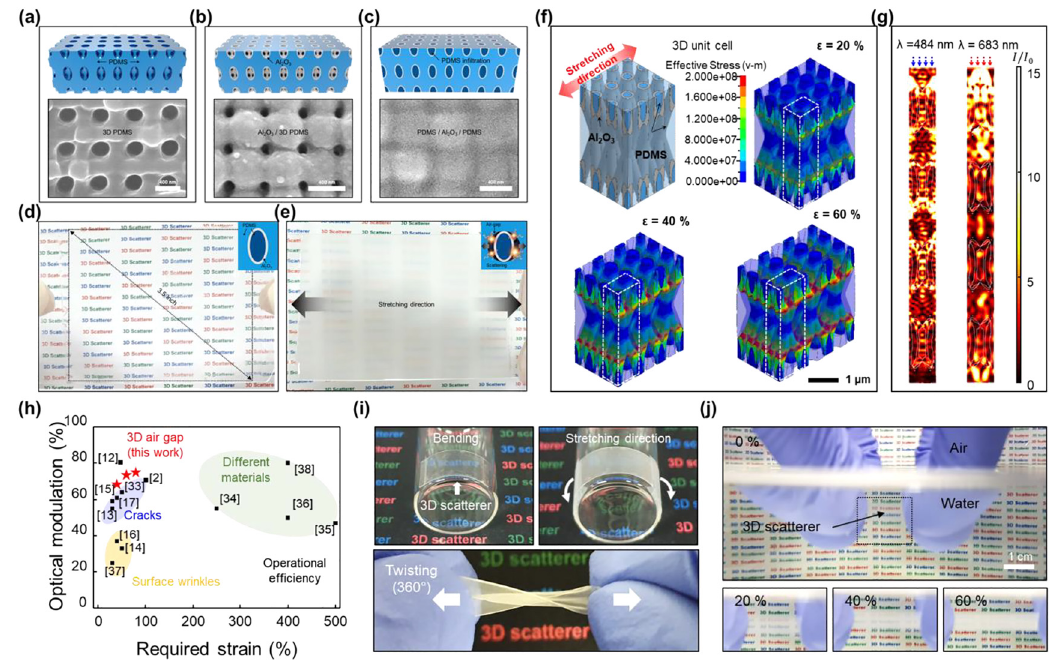
Figure 9: 3D scatterer with 3D heterogeneous interfaces in highly periodic 3D nanocomposite. (a) Fabrication of 3D PDMS, (b) the Al 2 O 3 -nanoshell-coated 3D PDMS, and (c) the hybrid nanocomposite in fi ltrated with PDMS. (d) Digital images of 3D scatterer before (transparent) and (e) after stretching (opaque). (f) Stress distribution in nine unit cells of a 3D scatterer with an Al 2 O 3 shell thickness of 60 nm under strains of 20, 40, and 60%. (g) Electromagnetic fi eld intensity distribution for 484 and 683 nm light passing through the 3D scatterer. (h) Comparison of the reported optical modulation performances with different types of the scatterers. (i) Robustness of a 3D scatterer under dynamic mechanical deformation and (j) water-immersion conditions. Reprinted with permission from Ref.